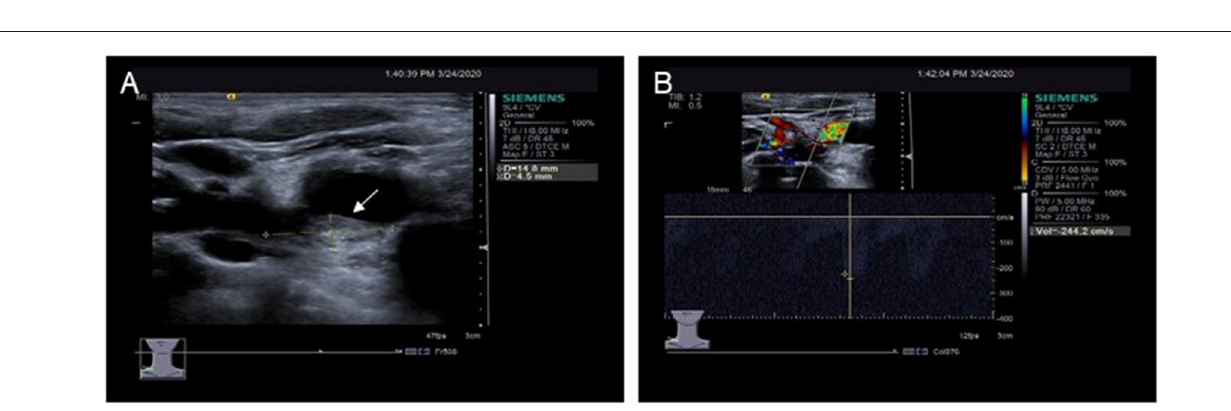
FIGURE 2 | CT scan of coronary arteries and abdominal vessels. (A) Coronary artery stiffness, left coronary artery segmental stenosis. (B–D) The abdominal aortic wall is thickened and unevenly dilated, and the opening of the proximal bilateral renal artery, the celiac trunk and the superior mesenteric artery are narrowed. CT, computed